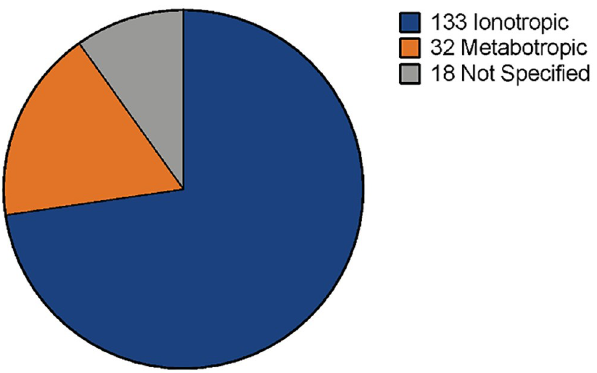
Fig 2. Contigs annotated as glutamate receptors in M. carcinus de novo transcriptome. Searching for glutamate receptor sequences within the new transcriptome resulted in 133 contigs identified as ionotropic glutamate receptors, 32 contigs identified as metabotropic glutamate receptors and 18 contigs identified as glutamate receptors without further